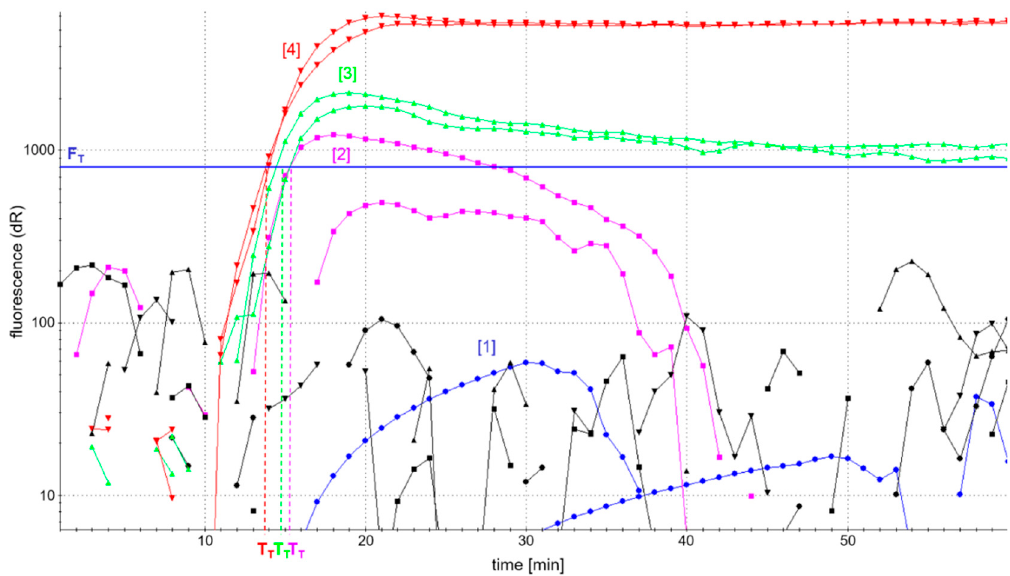
Figure 2. Optimization of the ratio of labeled biotin-FIP and FITC-LoopF primers in fluorescence-based real-time detection of the atpA gene. FIP / biotin-FIP and LoopF / FITC-LoopF primer ratios: blue [1] = 0:1, 0:1; magenta [2] = 0:1, 1:1; green [3] = 1:1, 1:1; red [4] = 1:1; 1:3; black = reaction without DNA template (NTC). Table 7. LAMP optimization parameters.